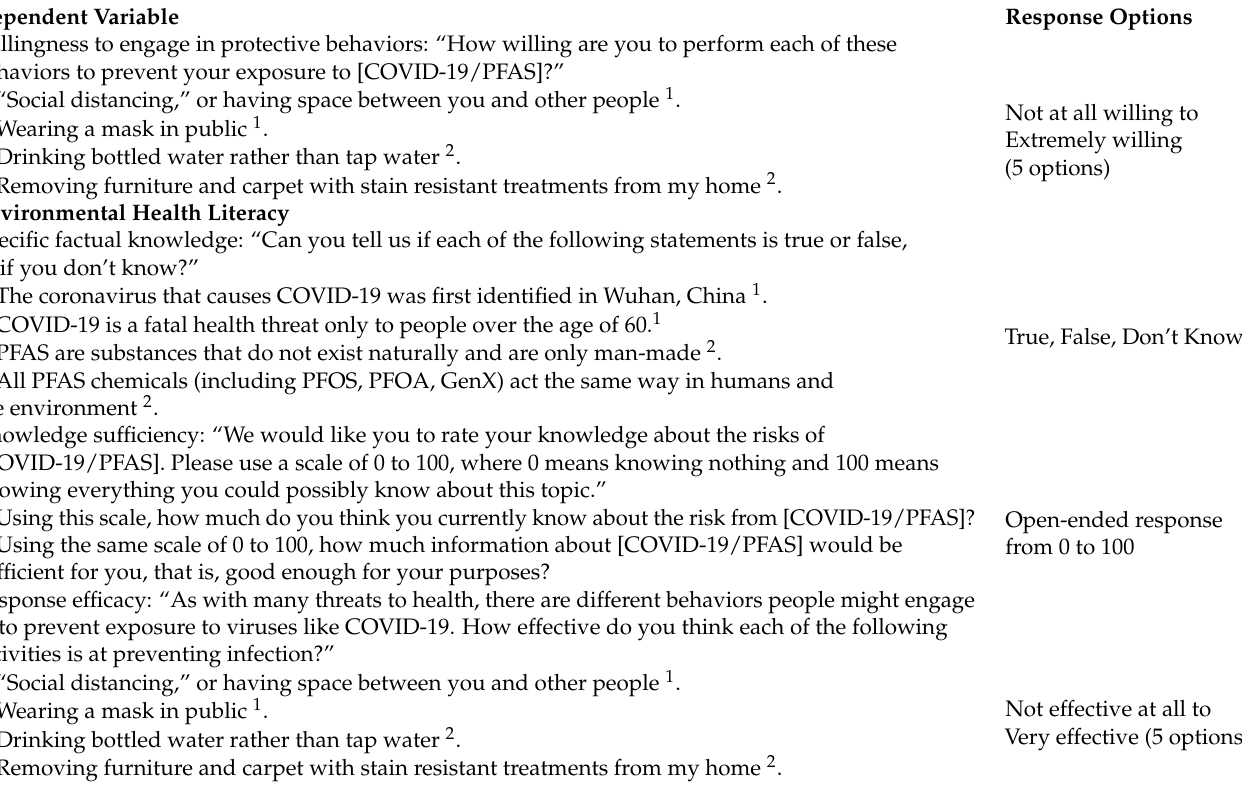
Table A1. Survey item wording for dependent variable and environmental health literacy